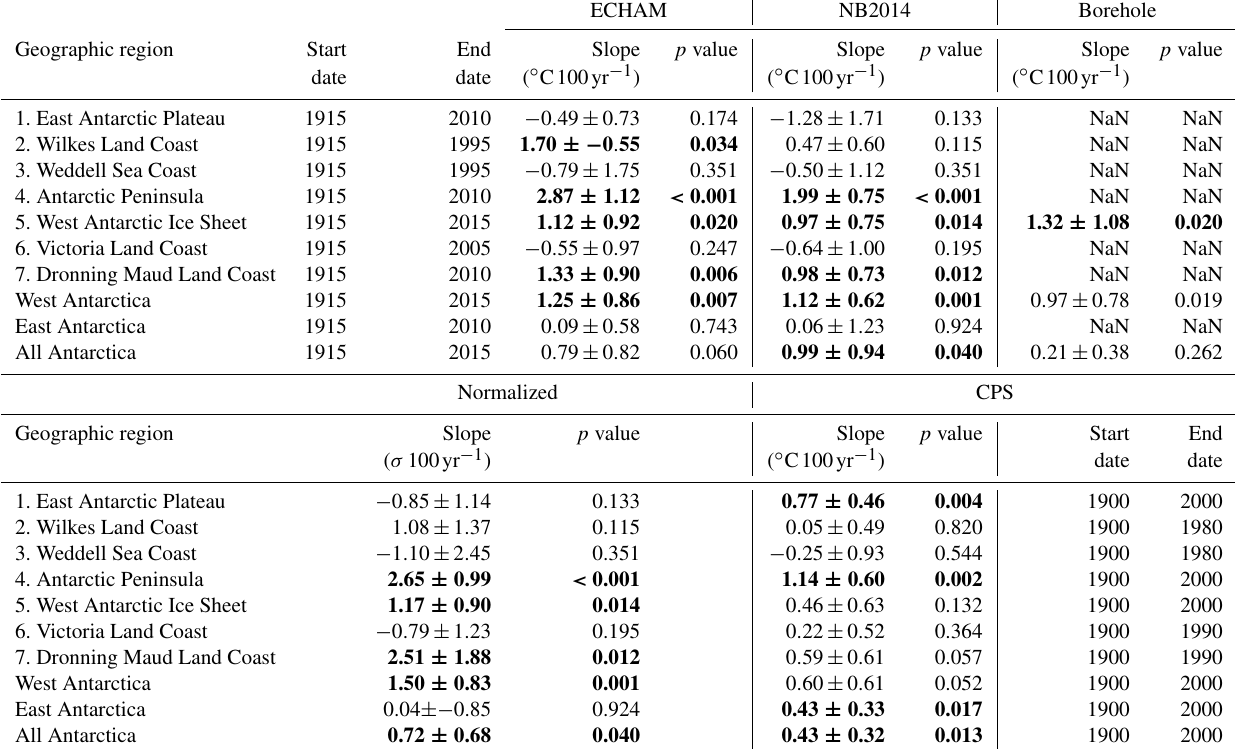
Table 4. Regression of the last 100-year slope based on the 5-year averages.